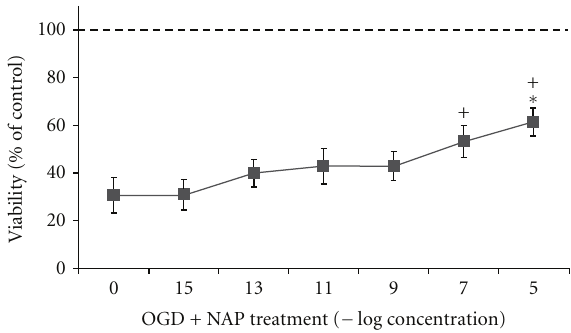
Figure 1: Culture purity: at 5-6 DIV, cells were fixed and immunofluorescence staining was performed using the astrocyte marker GFAP (green), the neuronal marker NeuN (red), and DAPI stain (blue) for nuclei. Quantification of neuronal cells was done using 10 random fields from each of 3 experiments ( × 20 magnification). 95 . 9 ± 0 . 96% of the total cells (DAPI stain) were recognized as neurons (NeuN positive, GFAP negative).